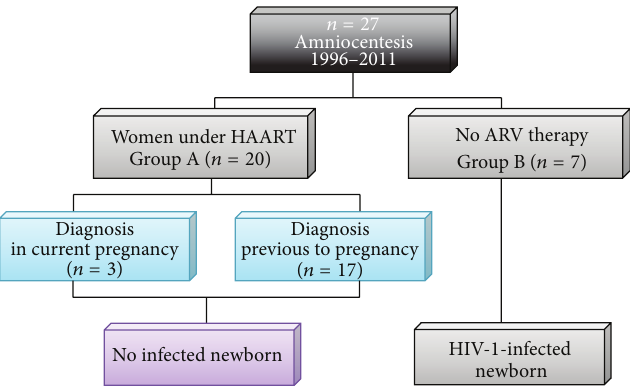
Figure 1: Summary of the study. HAART: highly active antiretroviral therapy; ARV: antiretroviral therapy.